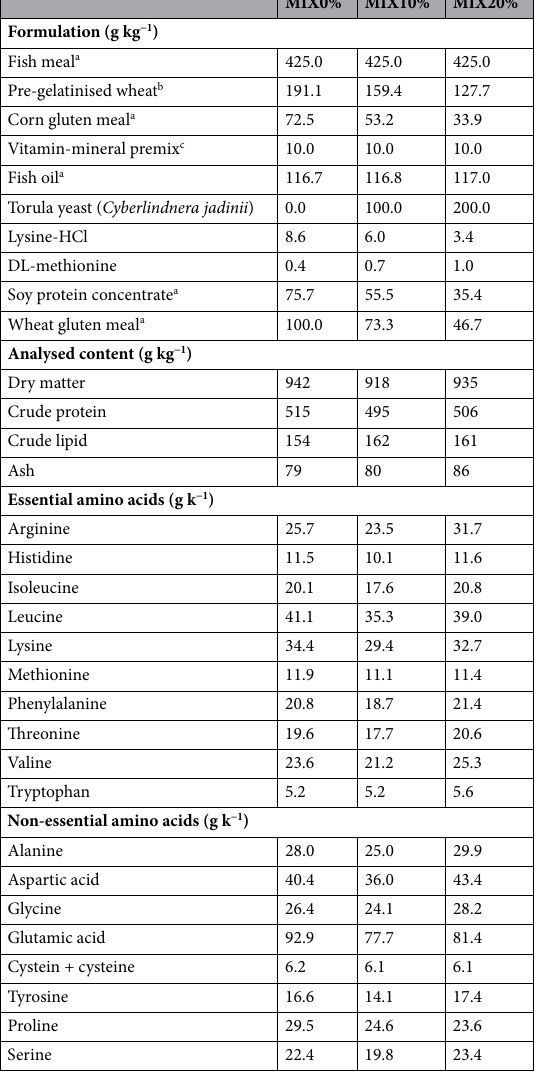
Table 2. Feed formulation and chemical composition for marine and plant protein combined (MIX) feed treatments. a Laxá hf. Krossanes, Iceland. b Emmelev A/S, Denmark. c Laxa salmon premix 2006 1%, Trouw Nutrition, The